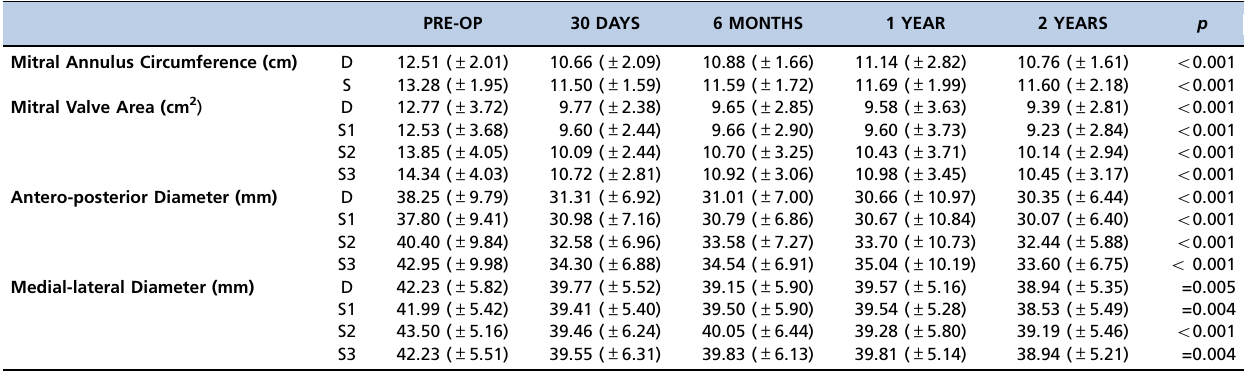
Table 2 - Measurements of mitral annulus circumference, performed in end diastole (D) and end systole (S) and mitral valve area and antero-posterior (AP) and medial-lateral (ML) diameters of the mitral annulus, performed in diastole (D) and during the three phases of systole (S1, S2,